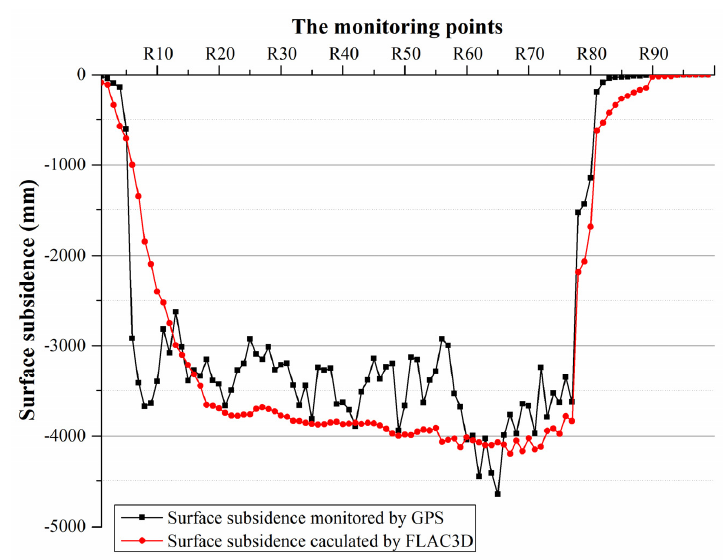
Figure 9. Comparison between the subsidence results of monitoring and FLAC 3D simulation (by adopting the parameters of Table 5) in panel No. 222201. Table 5. The optimal mechanical parameters of overlying strata obtained by parameter inversion, according to Scheme 5 of Table 4.